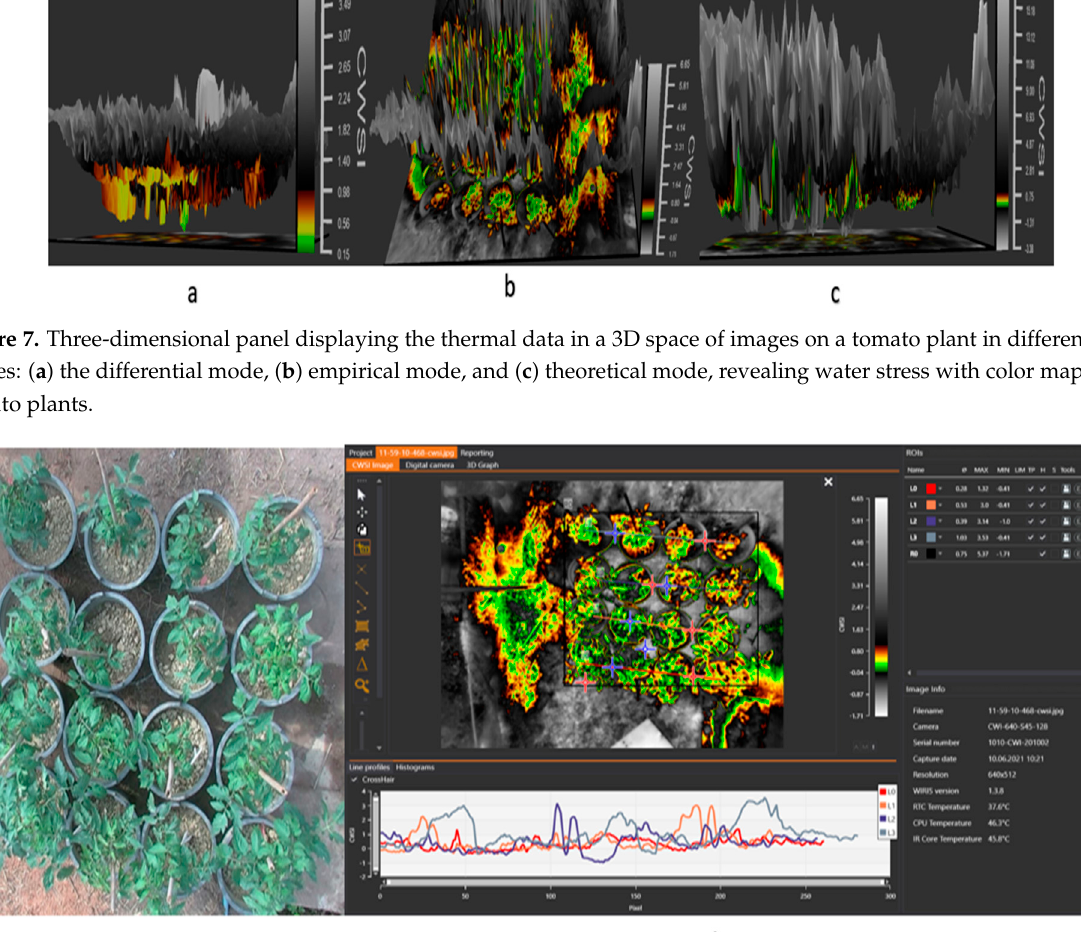
Figure 9. Relationship between the CWSI IDSO and CWSI W (( a ) sandy loam soil ( b ) silt loam soil) at different growth stages.